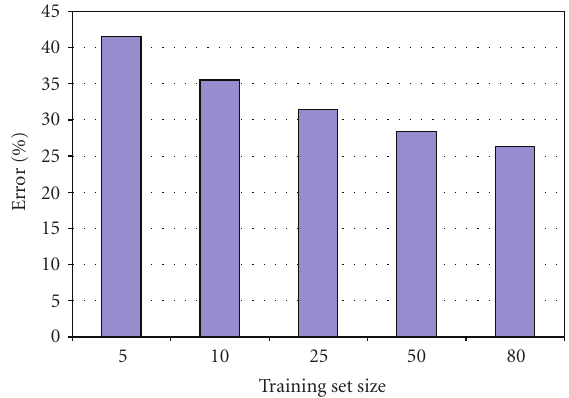
Figure 6: Averaged leave-one-out error obtained by the machine learning algorithm varying the number of game logs used for